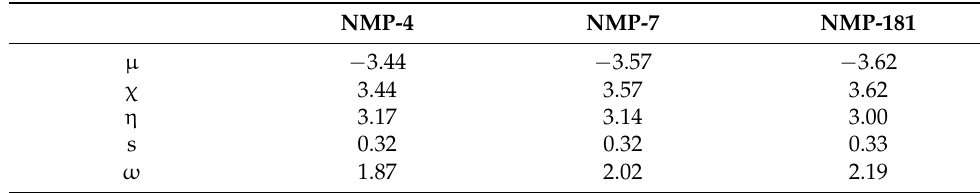
Table 2. Global reactivity descriptors (eV) for NMP compounds at BP86/cc-pVTZ level of theory in